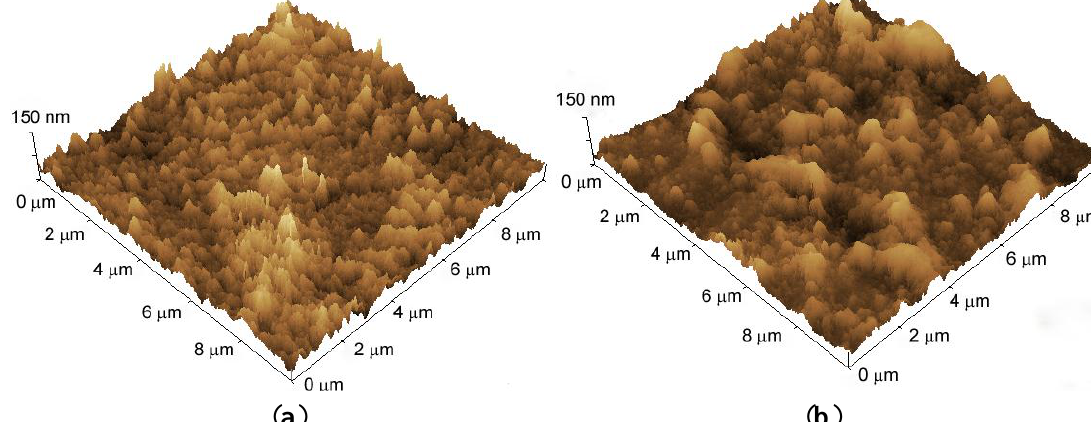
; and ( b ) PEI(PVS/CHI) 5 5